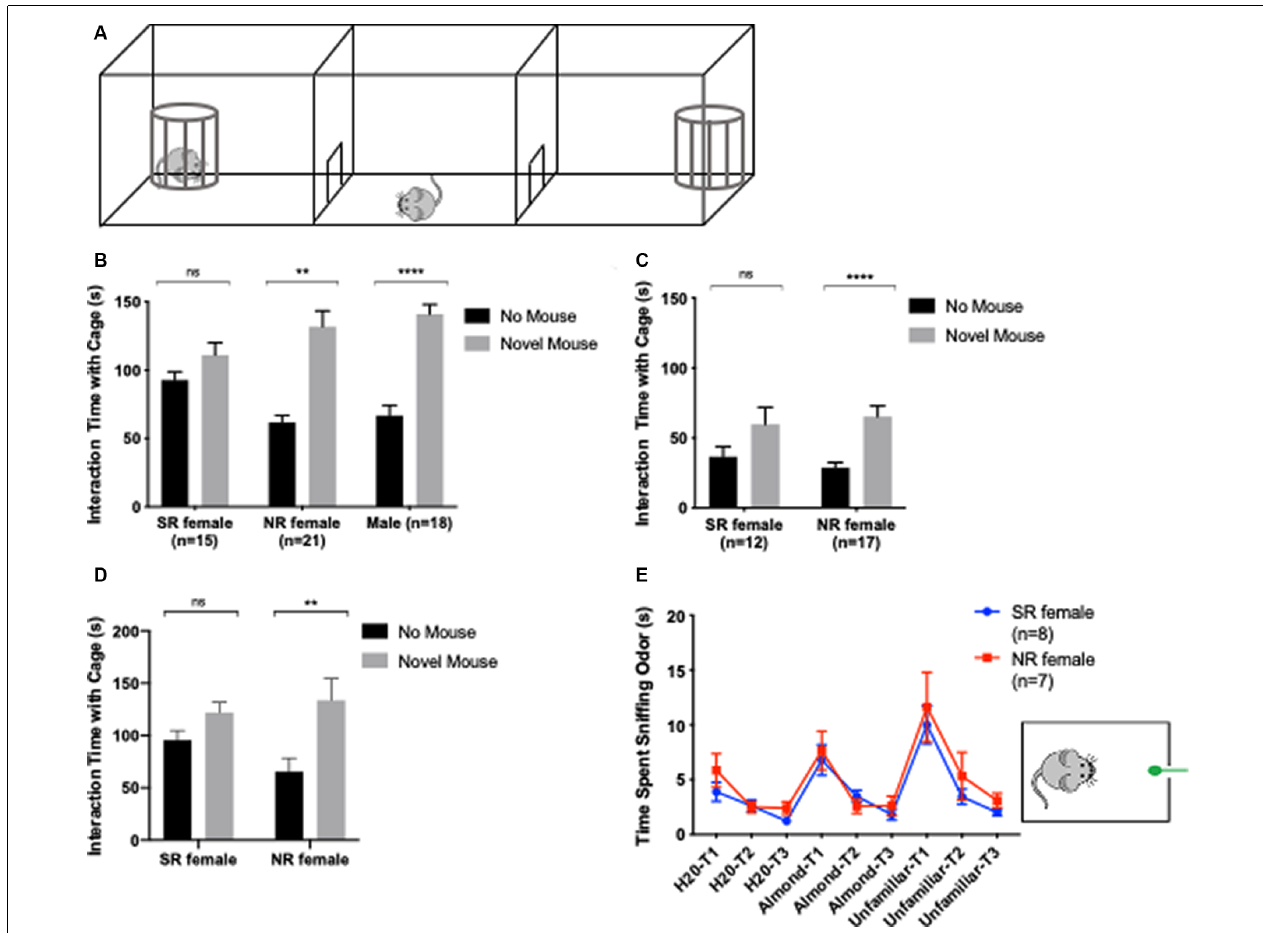
FIGURE 4 | An estrus cycle effect on the social behavior of female C57BL/6J mice. Apparatus for 3-chamber social interaction (SI). Cages for SI are traditionally barred (A) . In the SI task, NR females and males show a significant preference for novel same-sex mouse over a cage without a mouse. Sexually-receptive (SR) females show no preference for a novel mouse cage or a cage without a mouse (B) . In a visual SI task, where the cages are enclosed not barred, SR females still demonstrate an absence of preference for the novel mouse over a cage without a mouse (C) . Ten female mice were retested a second time in SI to compare interaction time when NR vs. SR. Two-way repeated-measures ANOVA was used with post hoc Bonferroni’s test to compare interaction time with novel vs. no mouse for each group (D) . Olfaction habituation/dishabituation test was used to determine differences in odor detection between NR and SR females. A mouse is exposed to cotton buds with odor in a habituated cage. SR and NR females demonstrate no significant difference in odor detection for distilled water (H 2 O), almond extract, and odor from a novel, unfamiliar same-sex mouse (E) . ** < 0.005, **** < 0.0001, ns > 0.05.